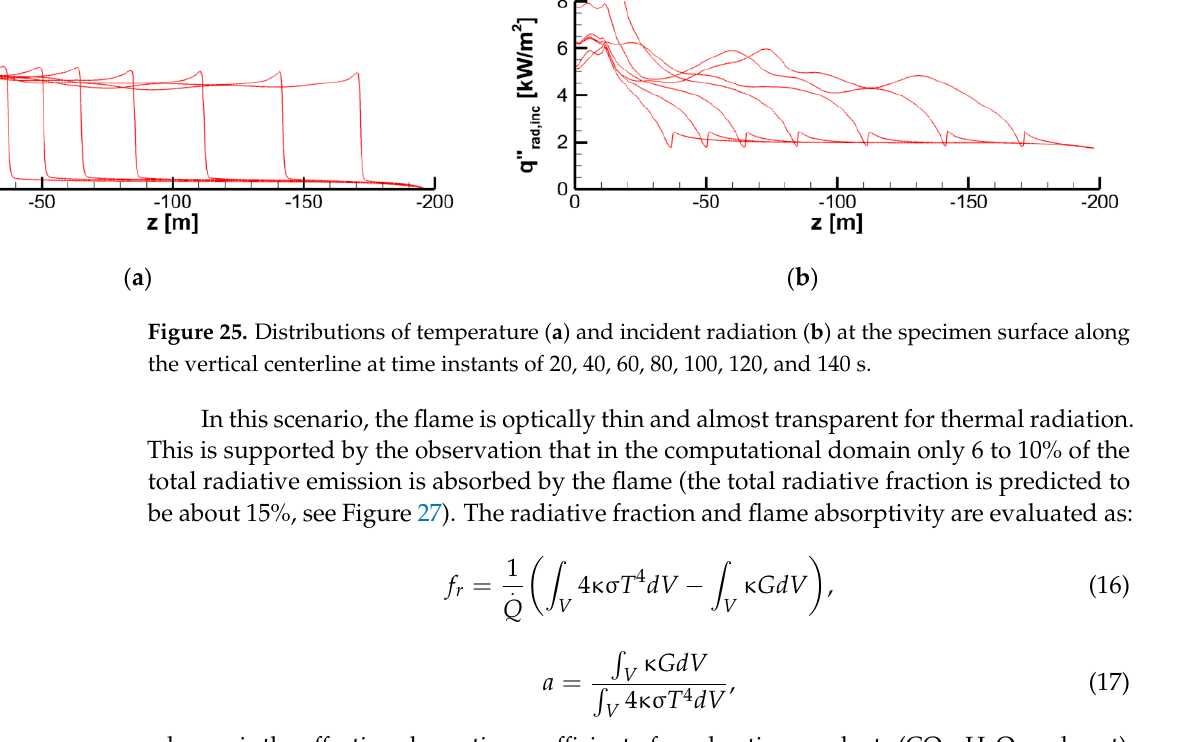
Figure 24. Distributions of radiative ( a ), convective ( b ), and net ( c ) heat fluxes and mass burning rate ( d ) over the specimen surface at time instant of 60 s. Dashed lines correspond to surface temperatures of 360, 380, 400, 600, 800, and 850 K. Maximum and minimum values of the heat fluxes and the burning rate are shown.